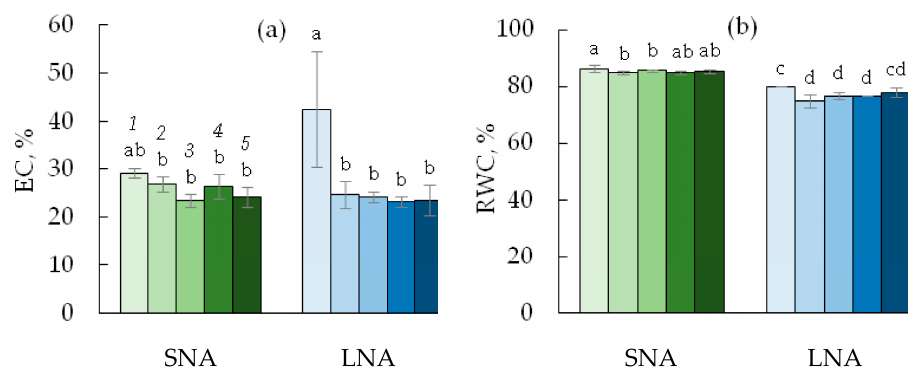
Figure 5. Electrolyte leakage (EC, ( a )) and relative water content (RWC, ( b )) in leaves of cucumber seedlings grown on the sandy loam soil with a sodium lignosulfonate concentration of 0 ( 1 ), 1 ( 2 ), 2.5 ( 3 ), 5 ( 4 ), and 10 ( 5 ) vol % under sufficient nutrient availability (SNA) or low nutrient availability (LNA). Significant differences at p < 0.05 indicated with different